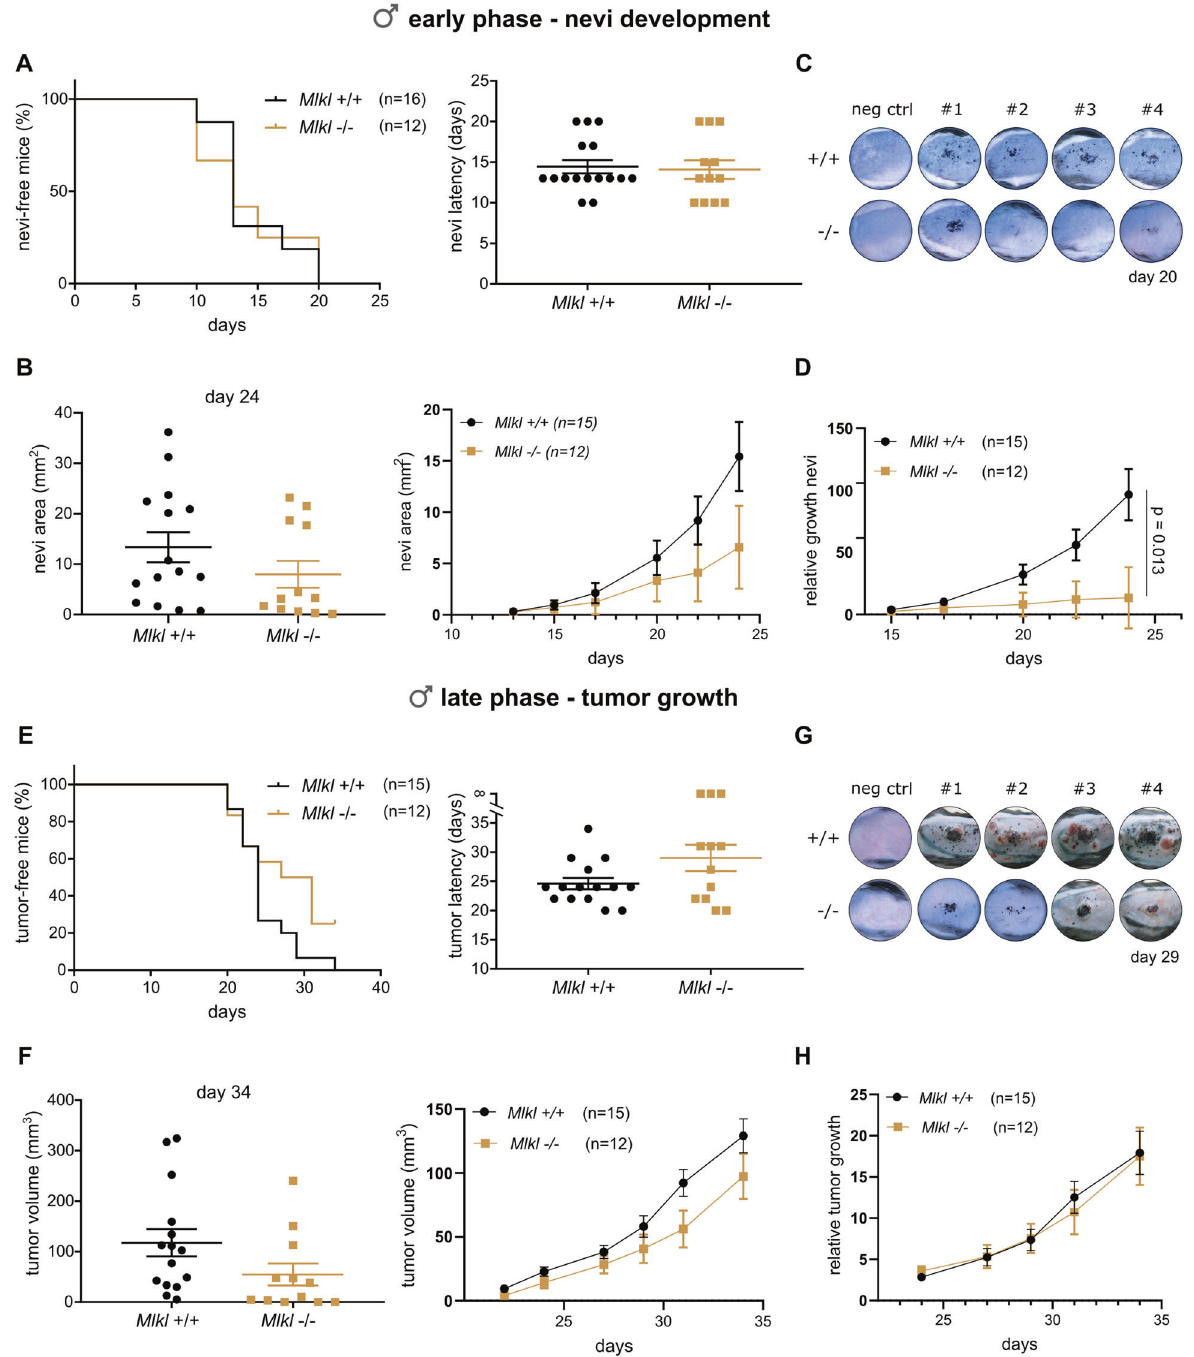
Fig. 2 MLKL modestly contributes to nevi growth in melanoma with Braf V600E Pten − / − background in male mice. Nevi ( A ) or tumor ( E ) latency and percentage of nevi/tumor-free male mice of Mlkl + / + and Mlkl − / − Braf V600E Pten − / − background were compared. Mean value and SEM are indicated. Log-rank (mantel-cox) test and unpaired two-tailed t -test were performed, respectively, but no signi fi cant result was obtained. Also, nevi area (mm 2 ) ( B ) or tumor volume (mm 3 ) ( F ) and relative nevi ( D ) or tumor ( H ) growth were calculated using ImageJ and caliper measurements, respectively. Relative nevi/tumor growth was calculated for each nevi/tumor by dividing its area/volume at every timepoint by the area/volume of the fi rst measurement. The line connects the mean values over time. Synchronization and repeated measurement analysis were performed to analyze differences over time. Nevi area (day 24) ( B ) and tumor volume (day 34) ( F ) are also illustrated (mean value ± SEM). Unpaired two-tailed t -test was performed. * p < 0.013. Dermatoscopic images of 4 representative nevi/tumor masses per genotype group at day 20 ( C ) and day 29 ( G ). Mice with Mlkl + / + or − / − Tyr : :CreERT2 + / + ;Braf V600Etg/ + ;Pten fl / fl background , challenged with 4-OHT, are indicated as negative